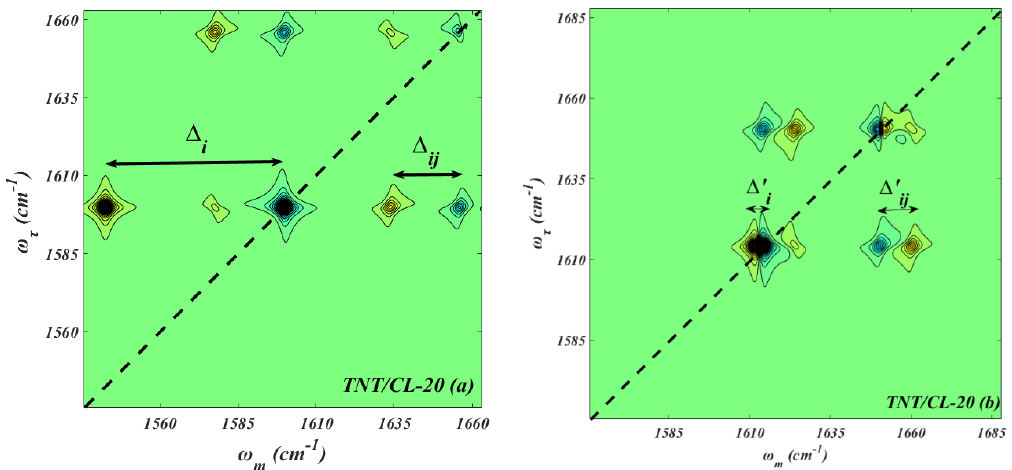
Figure 4. Normalized and simulated 2D IR spectra of NO 2 asymmetric stretching in TNT/CL-20. Intermolecular vibration energy transfer is the bridge of intermolecular interaction.